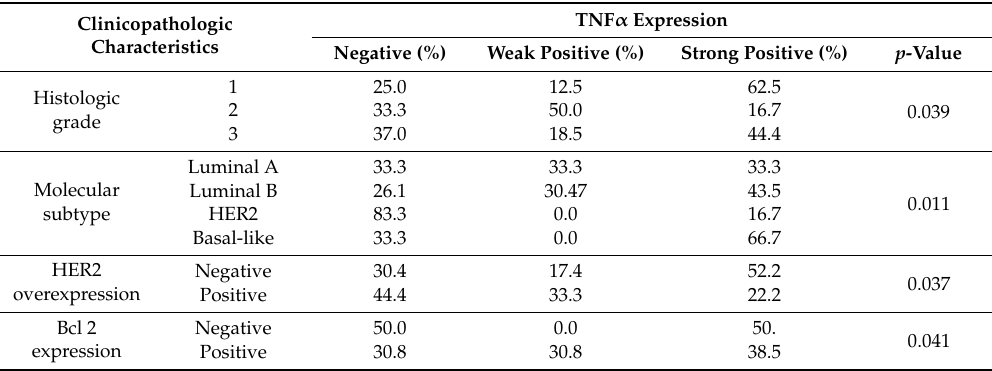
Table 4. Association between tumor necrosis factor α (TNF α ) and clinicopathologic characteristics in breast